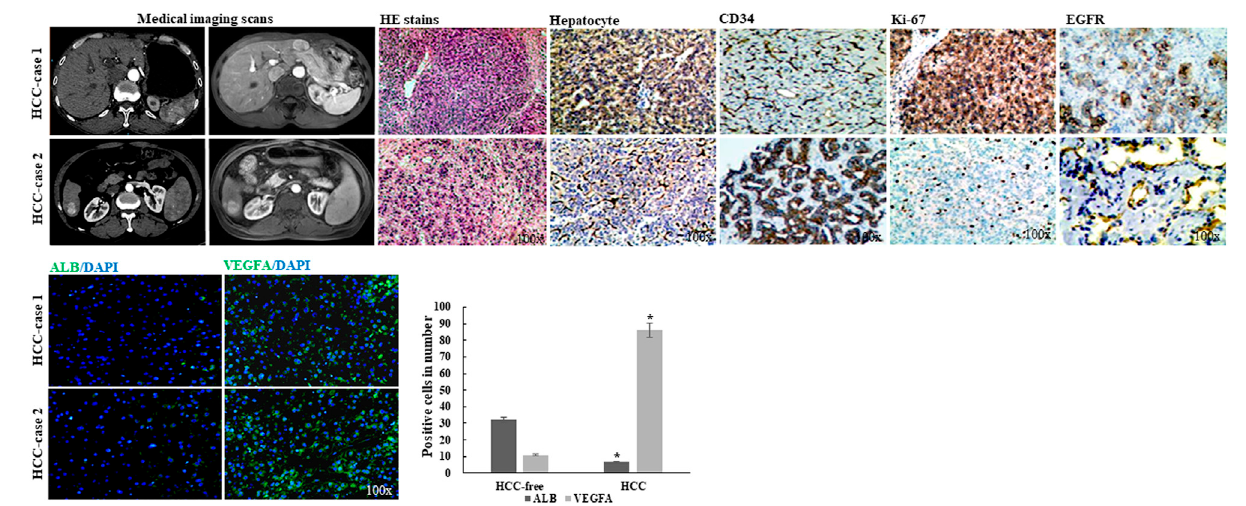
FIGURE 8 | Characterized imaging and immunostaining fi ndings of clinical HCC samples, and validated data based on molecular docking analysis.